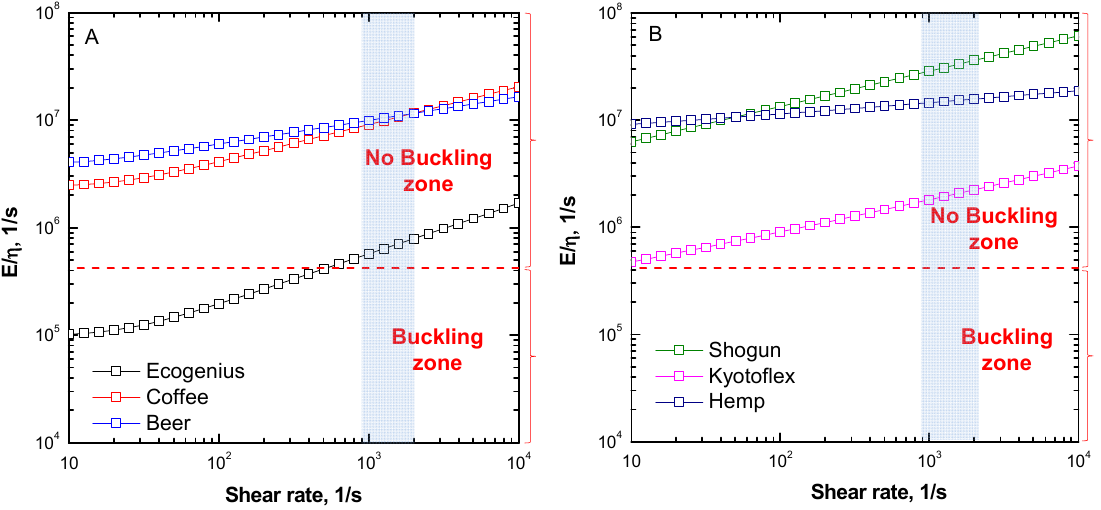
Figure 4. Typical buckling analysis performed on PLA-based materials showing ( A ) Newtonian plateau, and ( B ) yield stress.